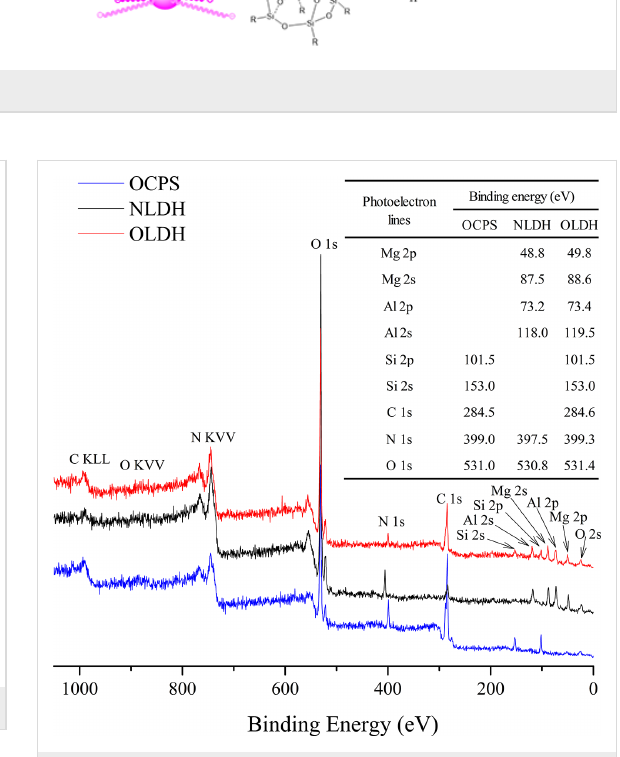
Figure 5: XPS spectra of OCPS, NLDH and